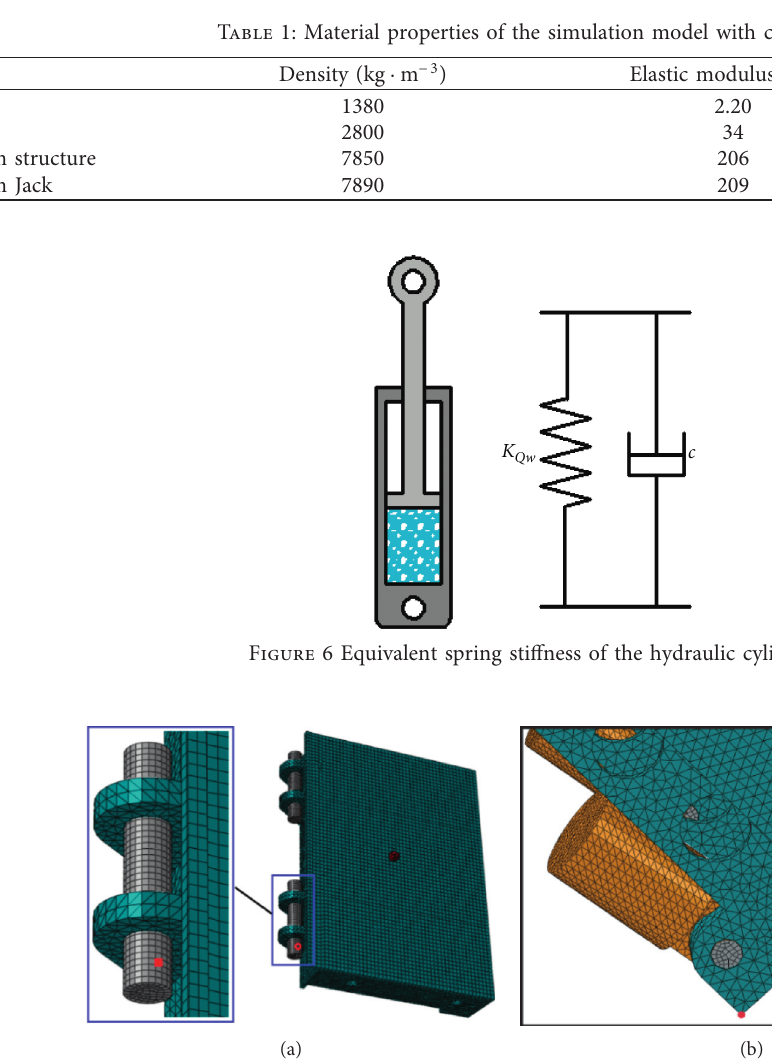
Figure 7: Test point positions of (a) pin shaft and (b) tail